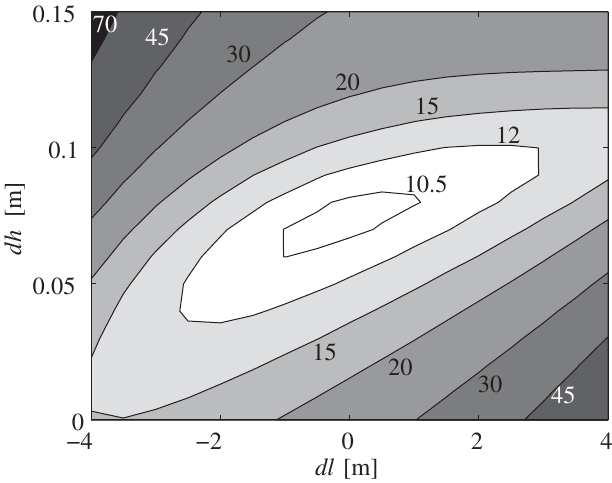
FIG. 11. Contour plot of the emittance growth versus longitu- dinal and horizontal dipole shift in an S-chicane with L 11 m .